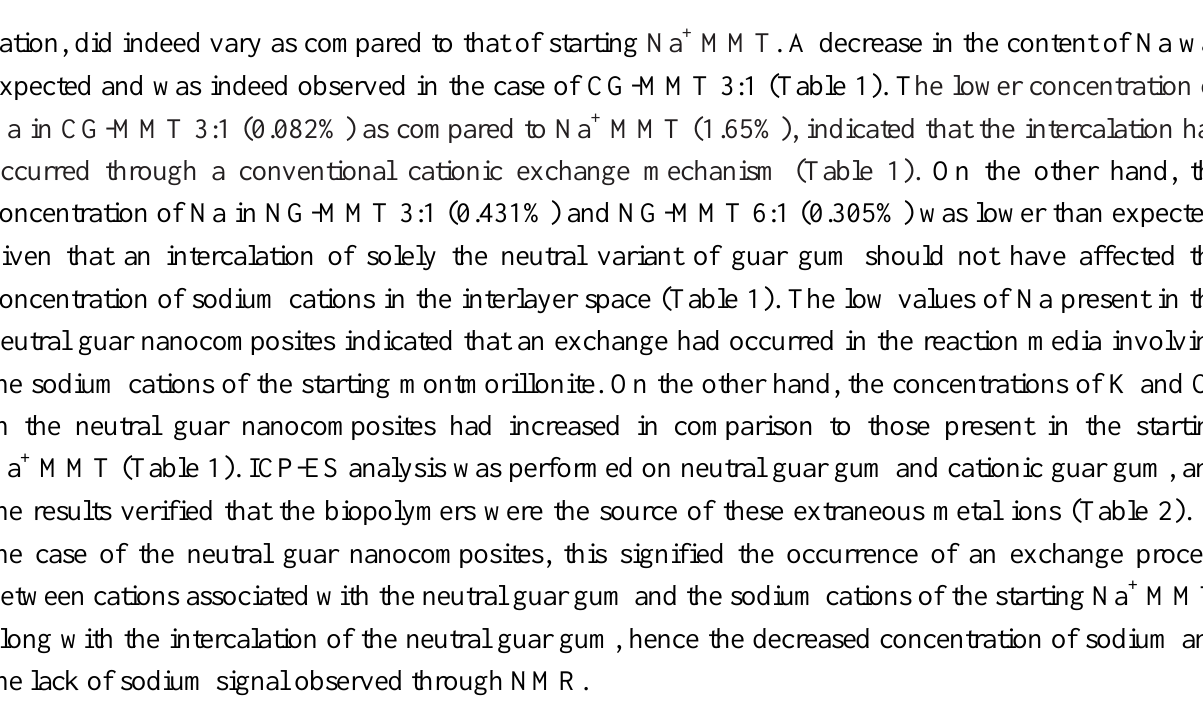
Table 1. Elemental Content Measured in starting Na + mineral montmorillonite (MMT) and the nanocomposites.